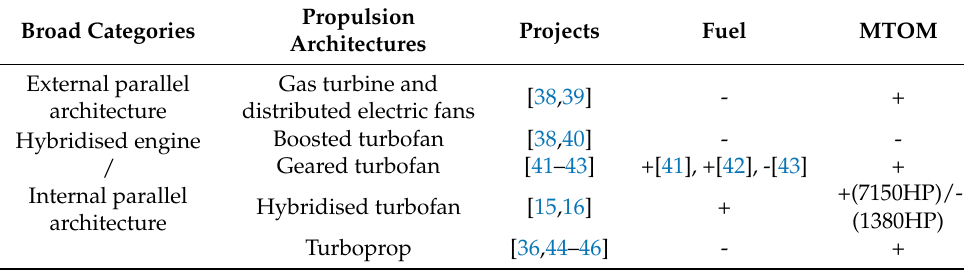
Table 1. Parallel HEP systems referenced in the